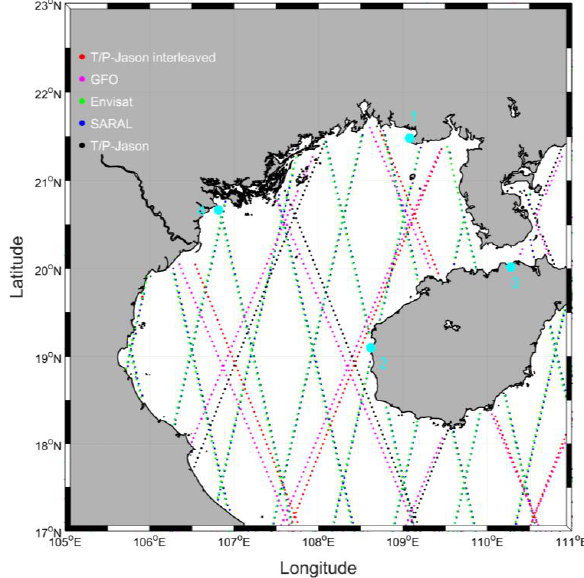
Figure 3. The ground tracks of multi-satellite altimeters and the locations of four long-term tide gauges (lightcyan dots) in the Gulf of Tonkin. 1, 2, 3, 4 represent Beihai, Dongfang, Haikou, and Hondau, respectively.